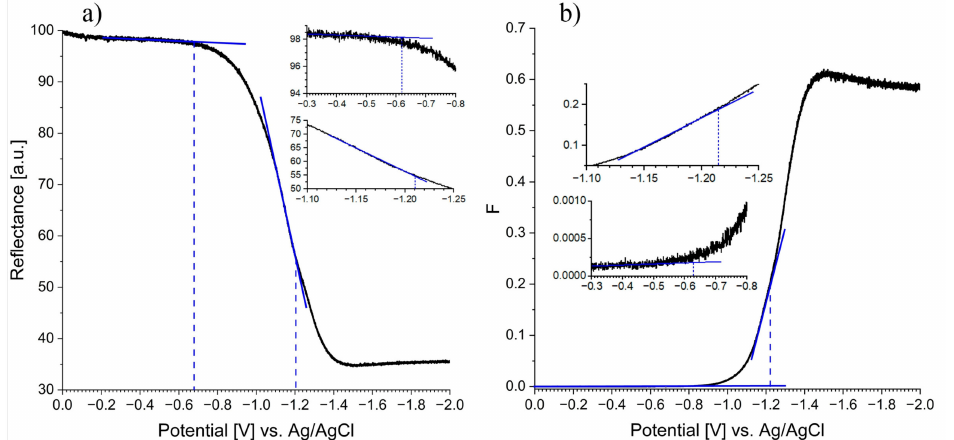
Figure 9. Reflectance at 780 nm ( a ) and Kubelka–Munk function ( b ) vs. polarization potential for the reduced black TiO x nanotubes. The electrode was polarized from 0 V to − 2 V vs. Ag/AgCl with a scan rate of 0.5